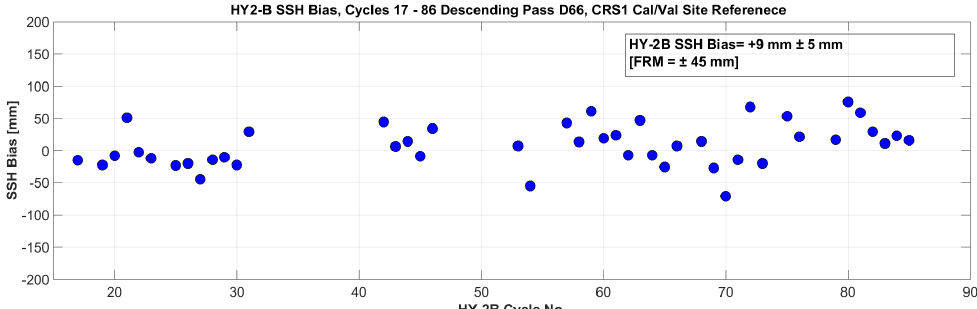
Figure 12. The sea-surface bias of the HY-2B satellite altimeter using the descending orbit D66 and based on the CRS1 Cal/Val site in West Crete. Cycles shown are from No. 17 (13 June 2019) to No. 86 (3 February